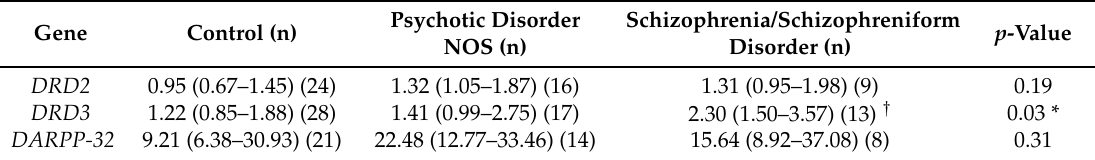
Table 2. Comparison of dopamine receptor D2 (DRD2), dopamine receptor D3 (DRD3), and dopamine